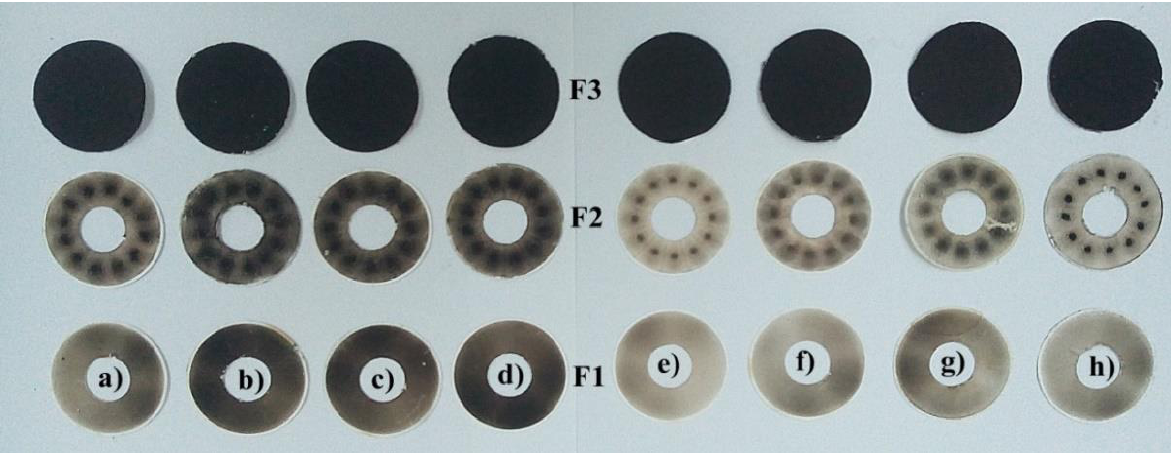
Figure 5. Sets of collection filters F1 PM > 10, F2 PM 10 – 2.5, and F3 PM < 2.5 for individual measurements of variant 1: ( a ) M1, ( b ) M2, ( c ) M3, ( d ) M4, ( e ) M5, ( f ) M6, ( g ) M7, and ( h ) M8.